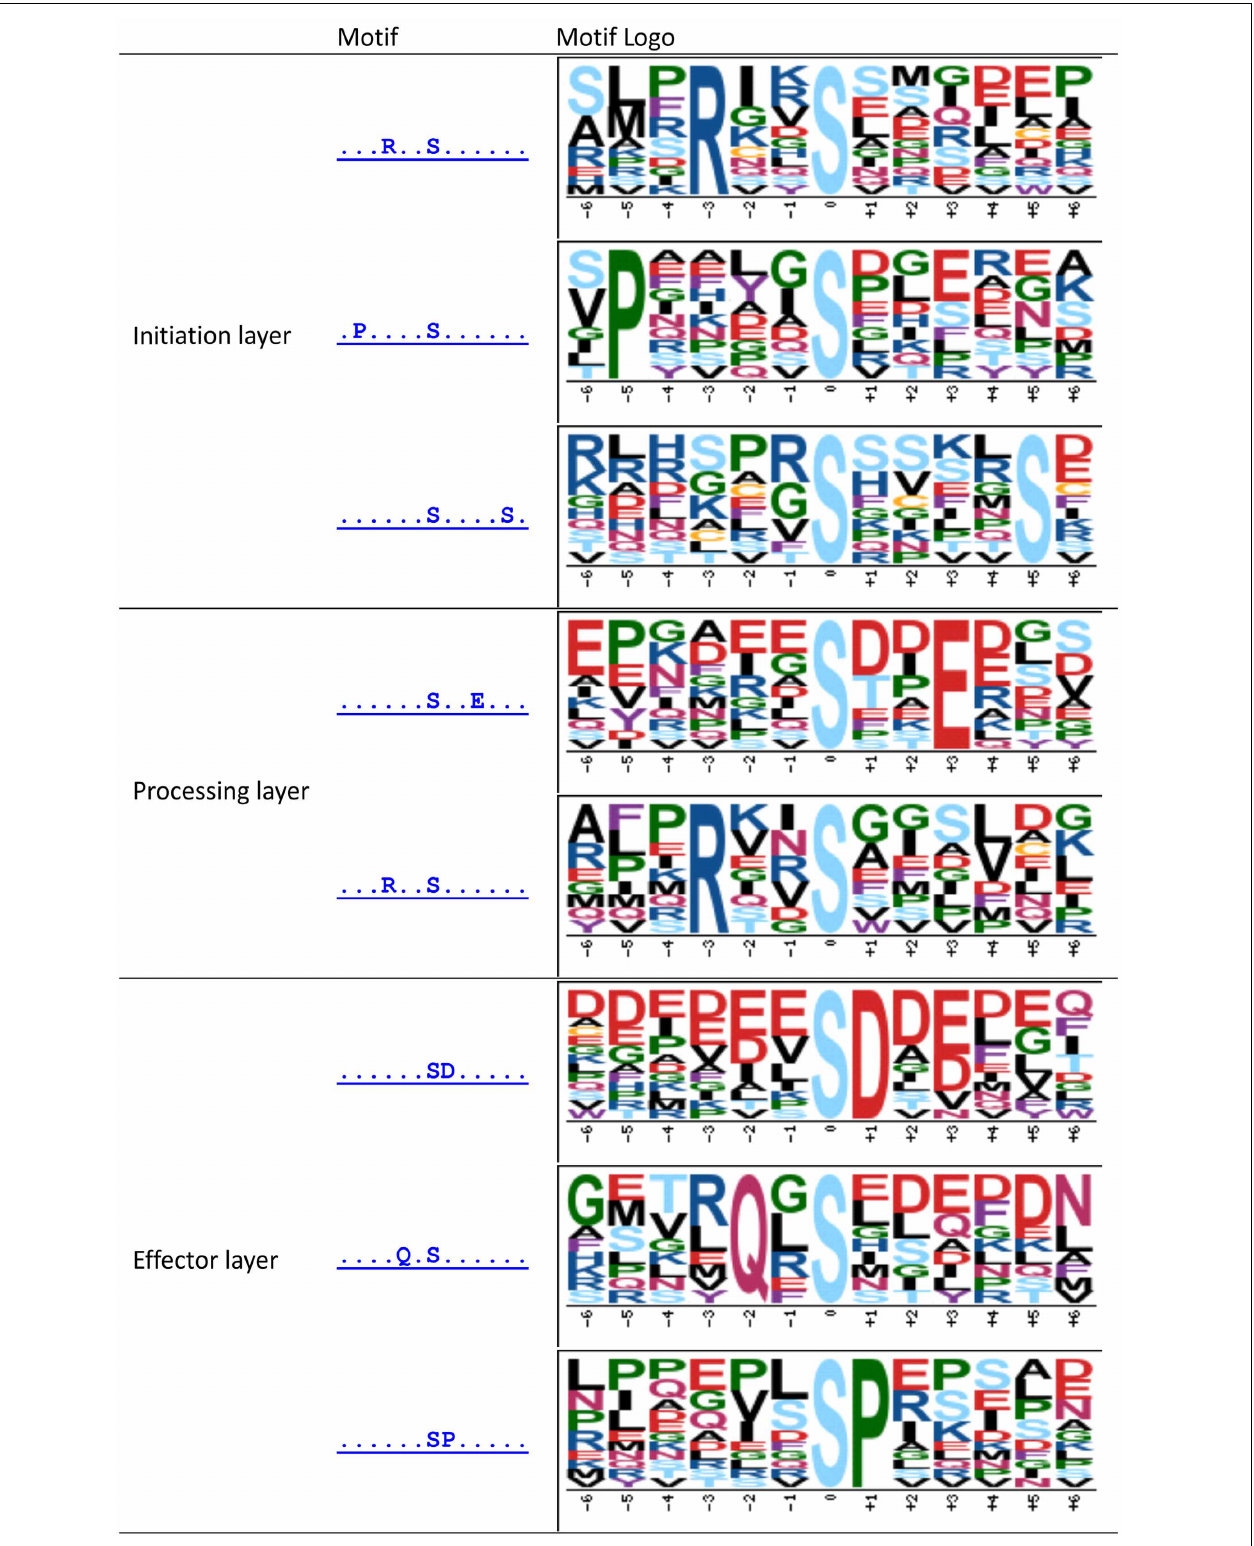
FIGURE 6 | Enriched motifs of phosphopeptides in different layer of the reconstructed network. Motif-x was used with p -value threshold 0.01, the occurrence threshold was set to 10.